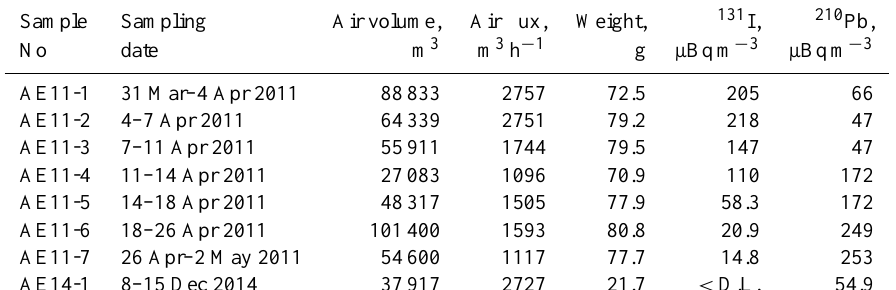
Table 1. Sampling information of aerosols collected at Risø, Denmark in 2011 and 2014. Data of 131 I and 210 Pb in the aerosol samples are adopted from the DTU Nutech report (Nielsen et al., 2011). The reference time was the mid-point of the sampling period, and analytical uncertainties were 5% for 131 I, and within 1% for 210 Pb).